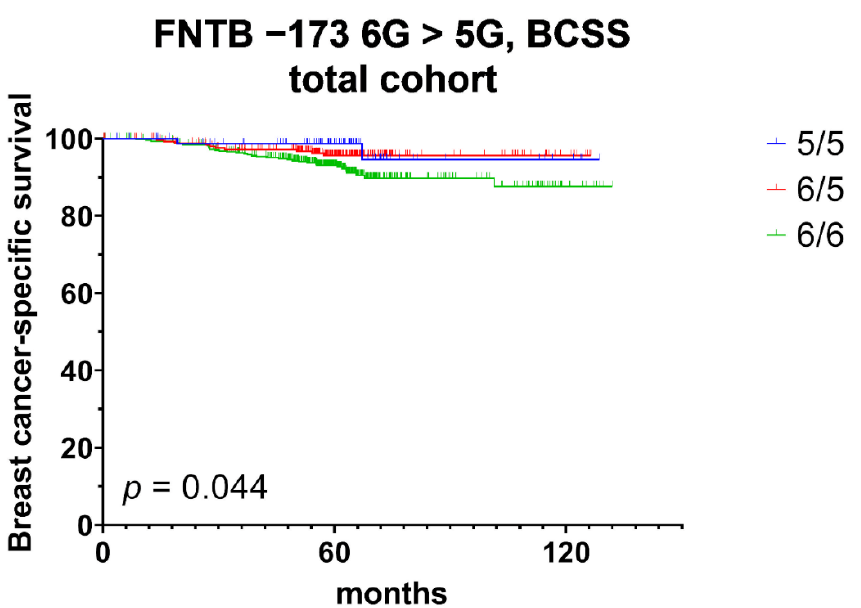
Figure 2. Kaplan–Meier analysis of breast cancer-specific survival (BCSS) in the total patient cohort stratified by promoter polymorphism rs3215788 (FNTB-173 6G > 5G) genotypes.